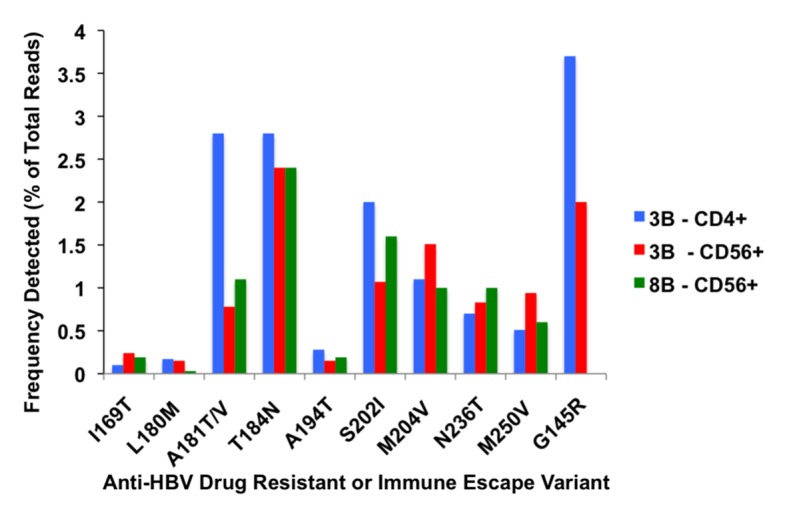
Frequency (% of total reads) of HBV drug-resistant and immune escape (i.e., G145R) mutations detected in CD4+ and/or CD56+ immune cell subset by deep sequencing analysis in 2 HBV monoinfected cases (i.e., #3B and #8B) on tenofovir anti-HBV therapy.